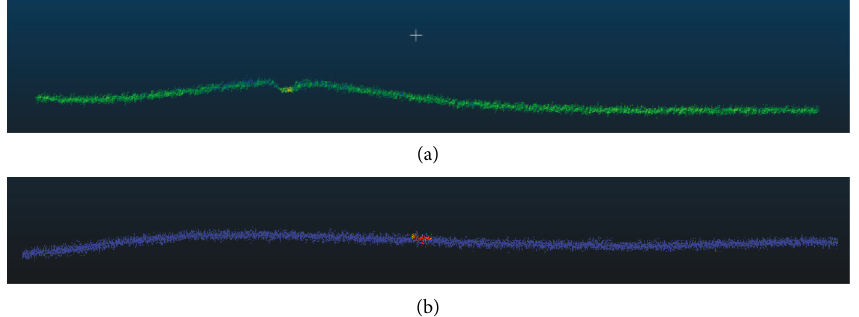
Figure 10: Cross section of point cloud. The cross section image of (a) large crack and (b) shallow small crack. The continuous change of elevation and high density point lead to the unsignificant of difference in